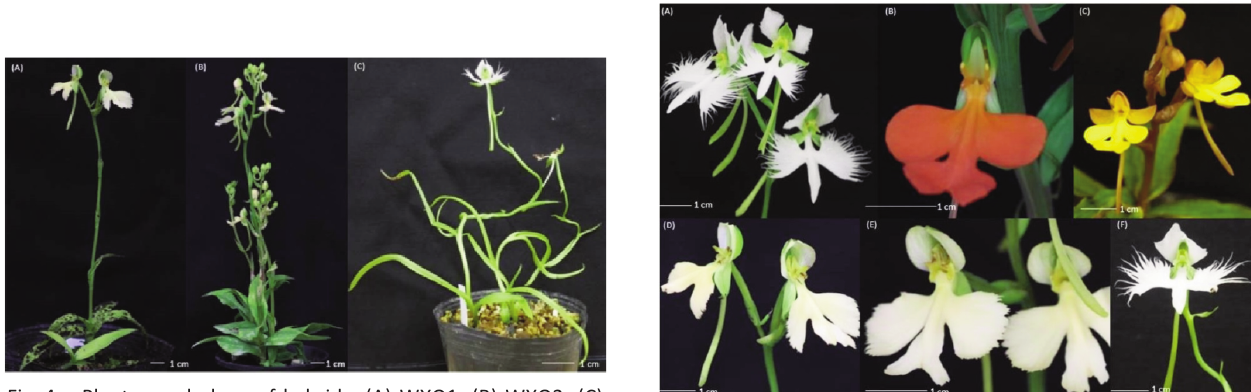
RCO.Fig. 4 ­ Plant morphology of hybrids. (A) WXO1, (B) WXO2, (C)